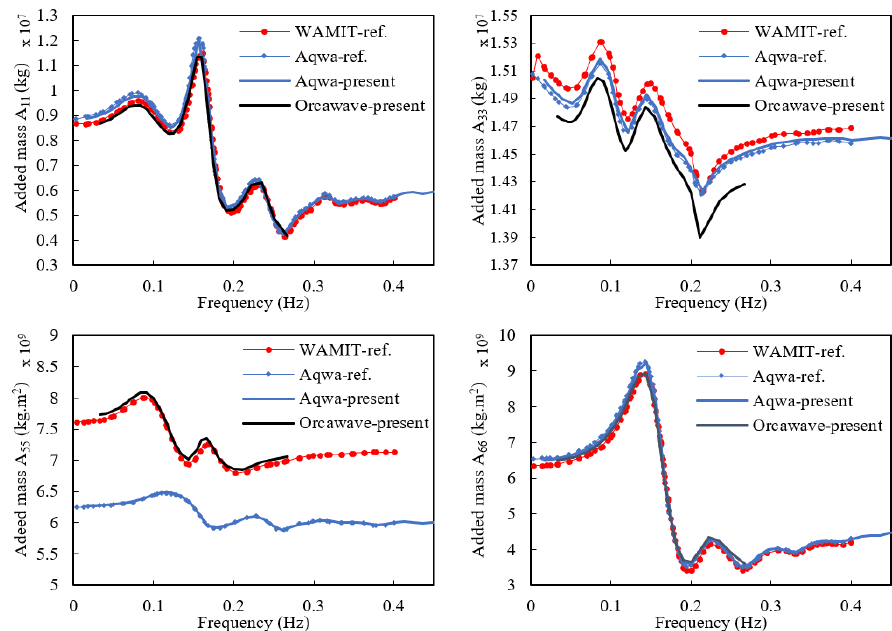
Figure 2. Diffraction analysis technique validation result (added mass).